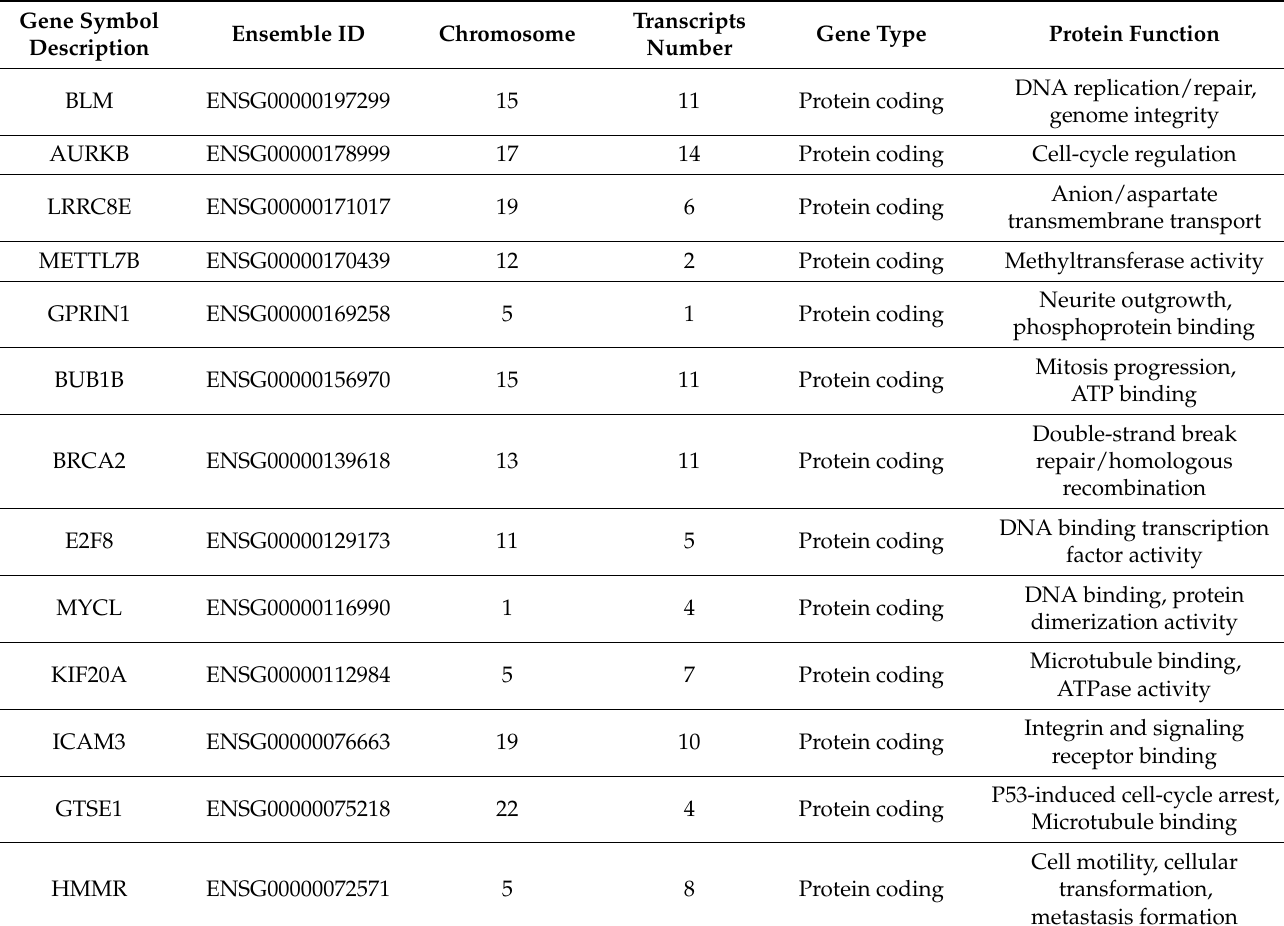
Table 2. Functional characterization of the 13